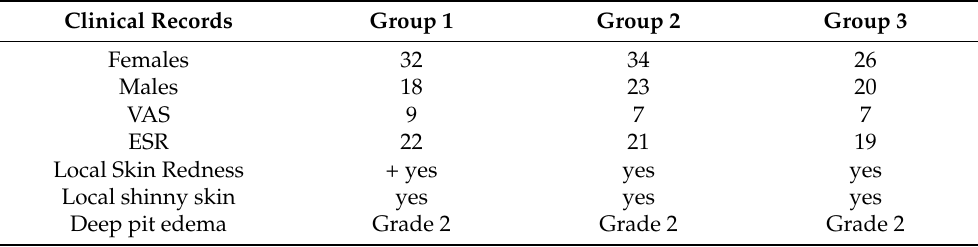
Table 1. Clinical characteristics of the patients at the time of enrollment. Group 1: patients treated with fondaparinux (7.5 mg/day) and then nattokinase (100 mg/day). Group 2: patients treated with